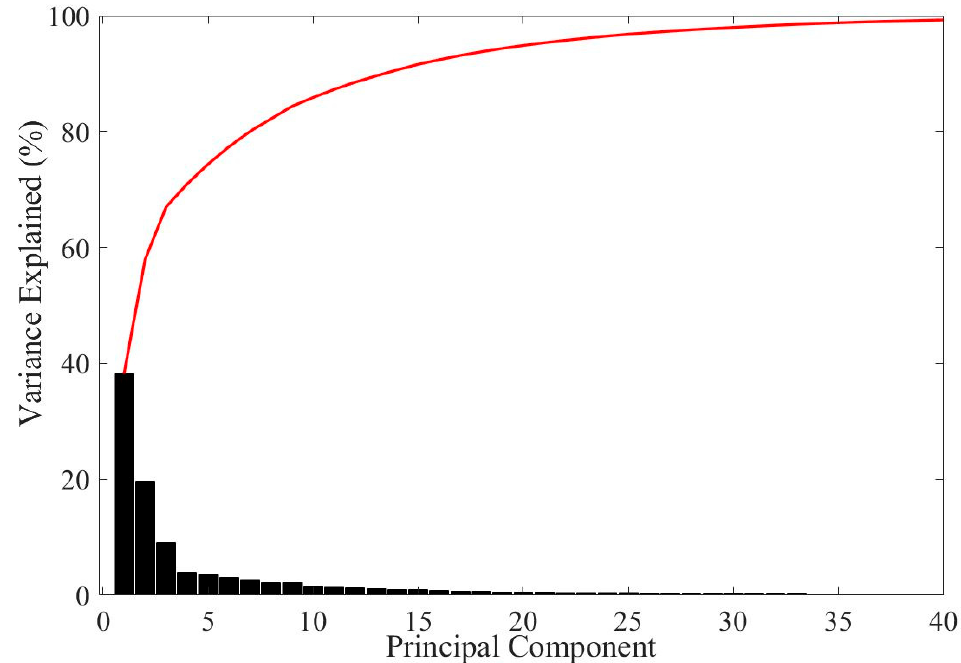
ff erent principal